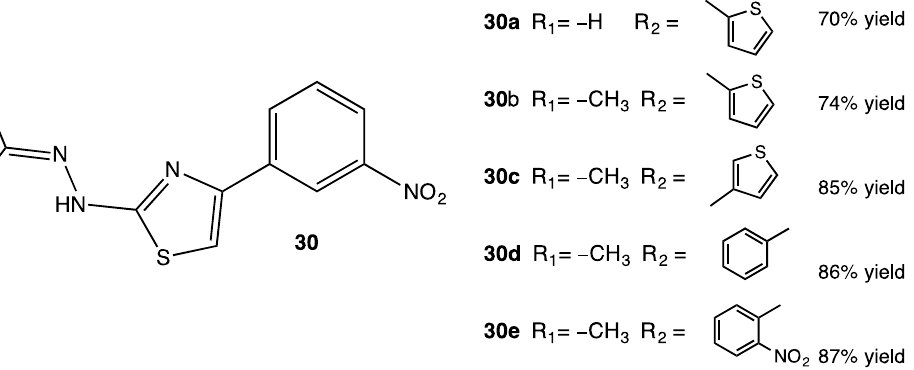
Figure 15. Structures of compounds showing a high and selective inhibition of MAO B [59].